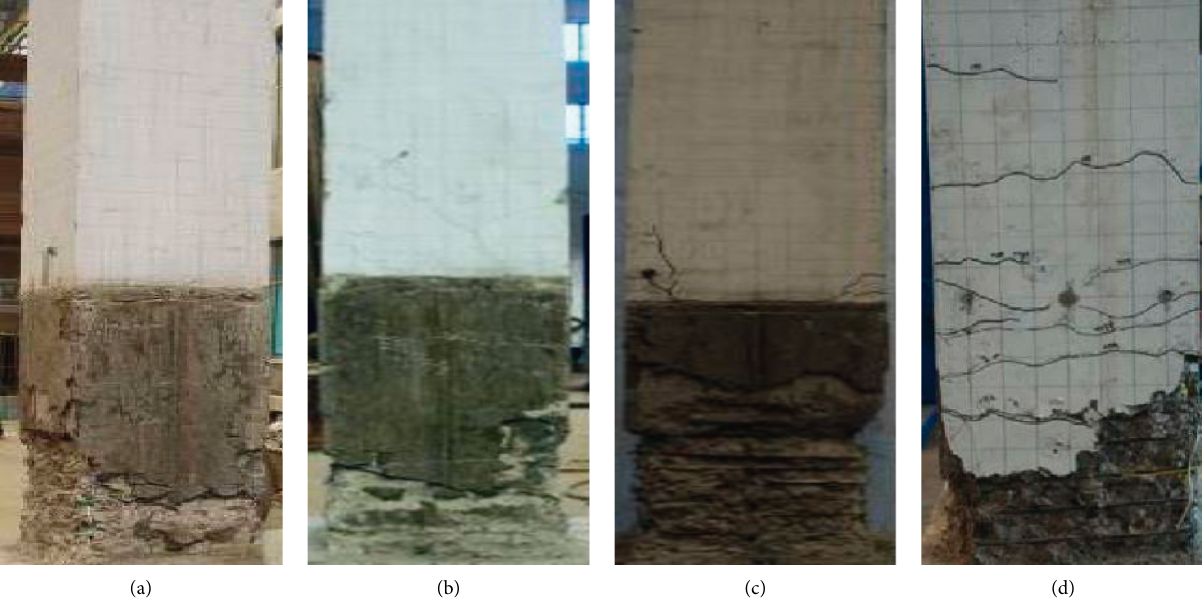
Figure 4: Failure form of specimens. (a) W01. (b) W02. (c) W03. (d) XJ-01.